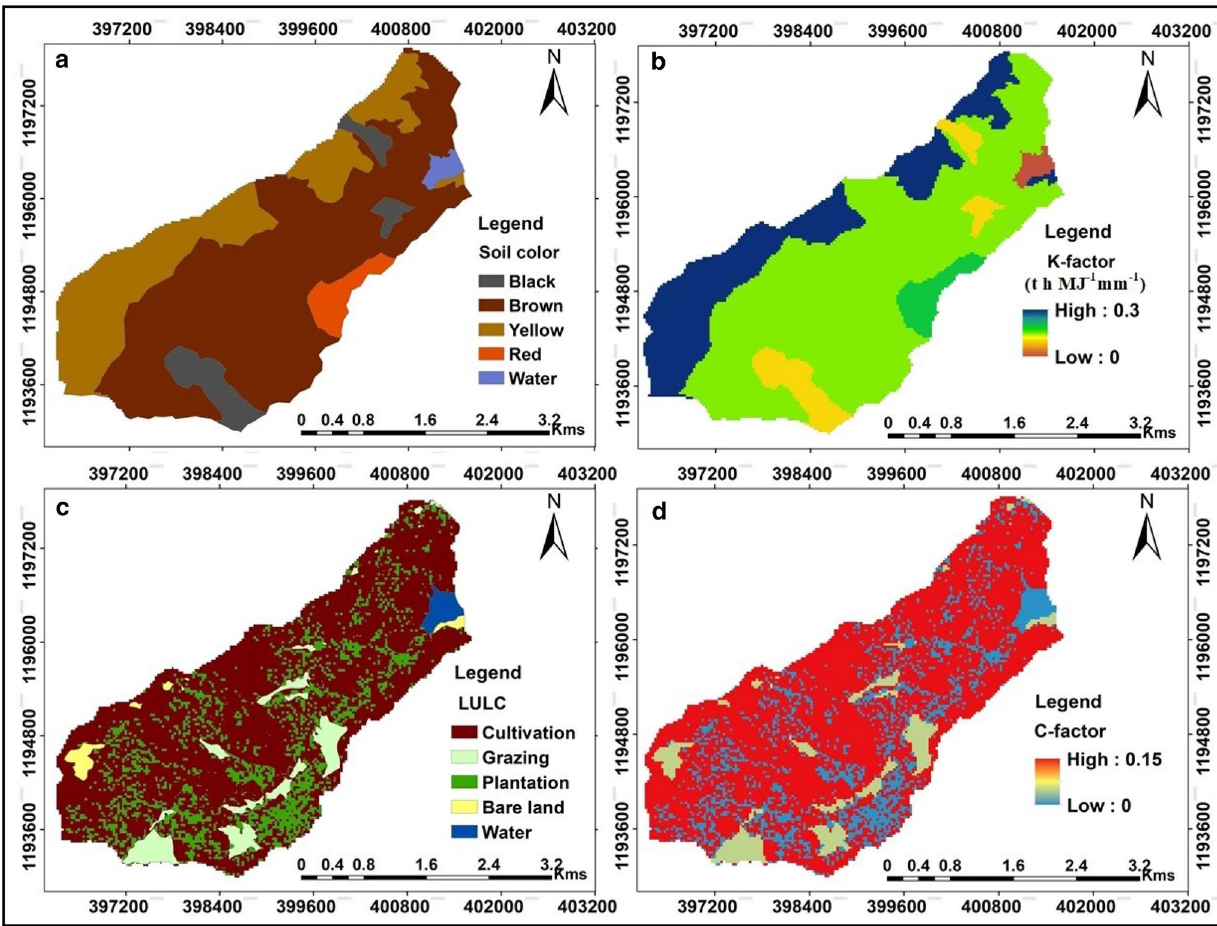
Fig. 4 Soil color ( a ), K-factor ( b ), LULC ( c ), C-factor ( d ) maps of the watershed